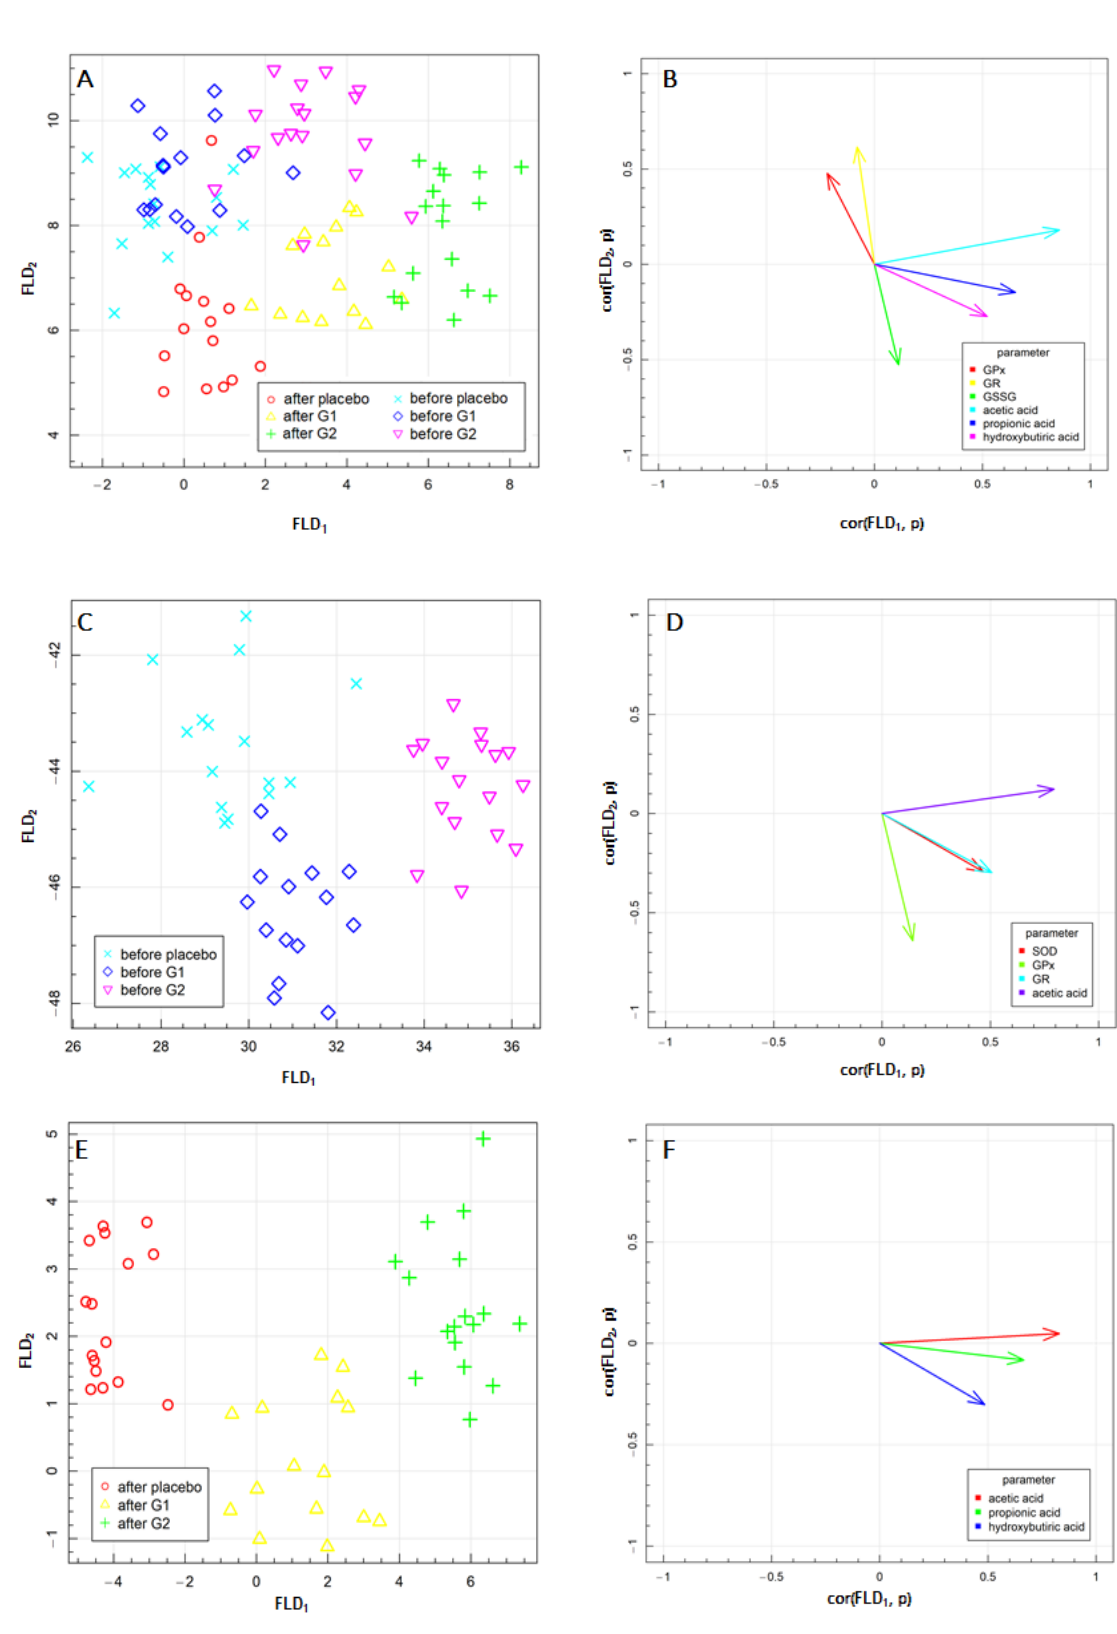
Figure 4. Fisher’s Linear Discriminant (FLD) Analysis: ( A , C , E ) experimental data on the plane spanned by two the most data separating FLDs and ( B , D , F ) parameters contributing the most to FLDs. ( A , B )—before and after the beta-glucans intervention; ( C , D )—before the beta-glucans intervention; ( E , F )—after 30 days of the beta-glucans intervention.